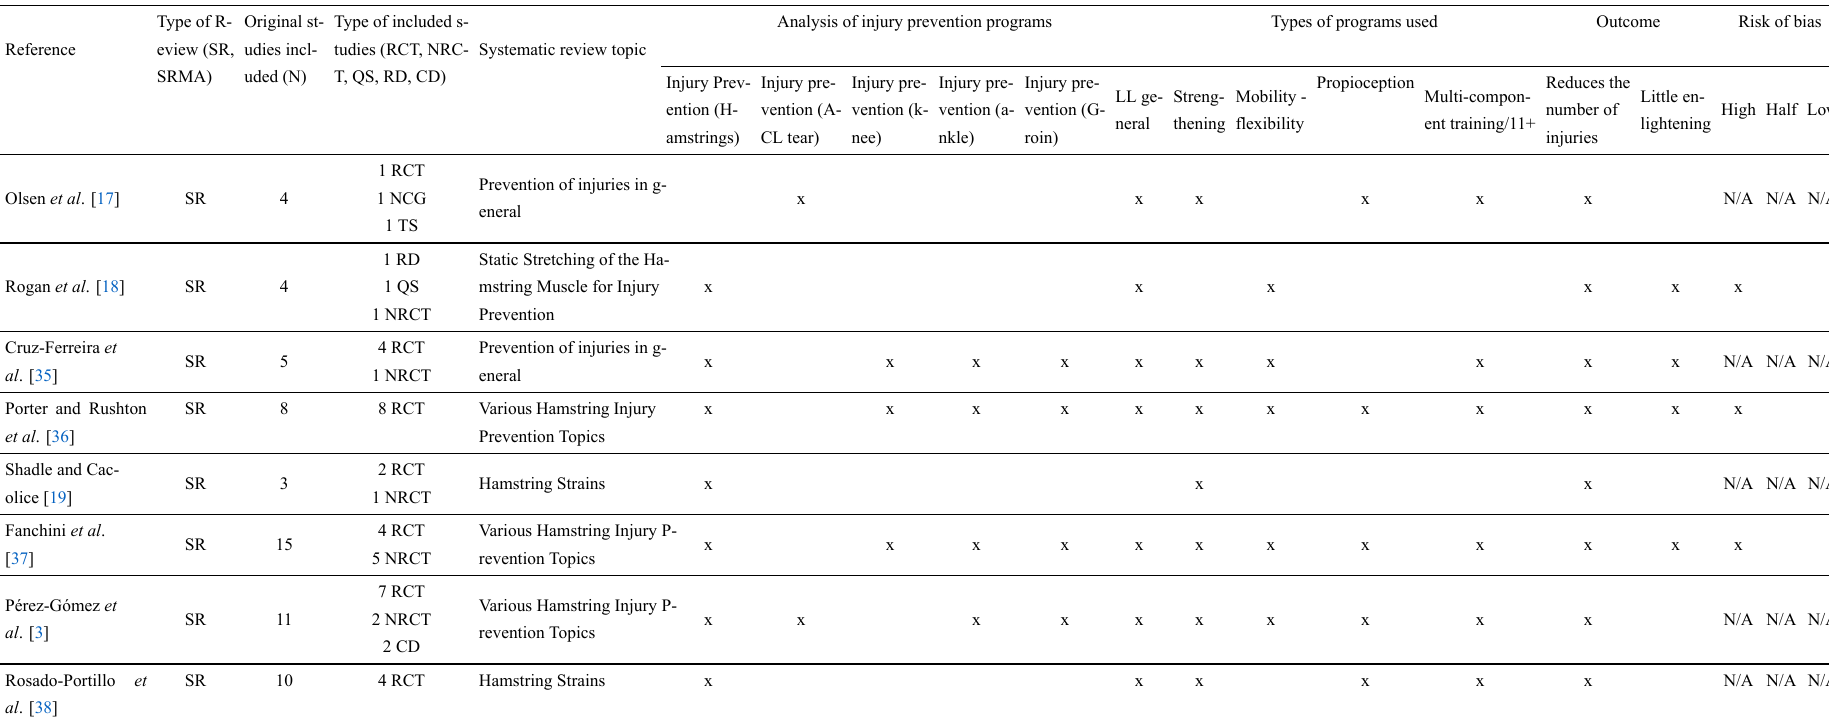
Table 2. Summary of the eligible articles’ characteristics included in the umbrella